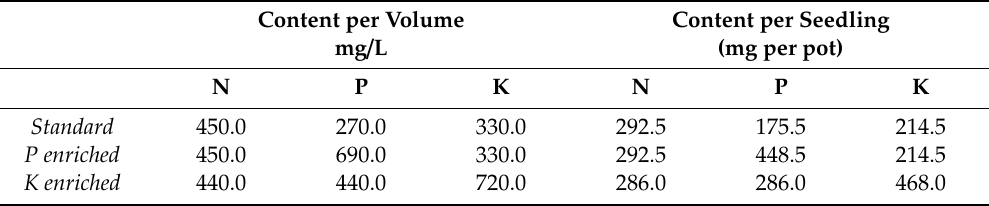
Table 1. Macro-elements (NPK) content (per volume and per seedling) in the studied